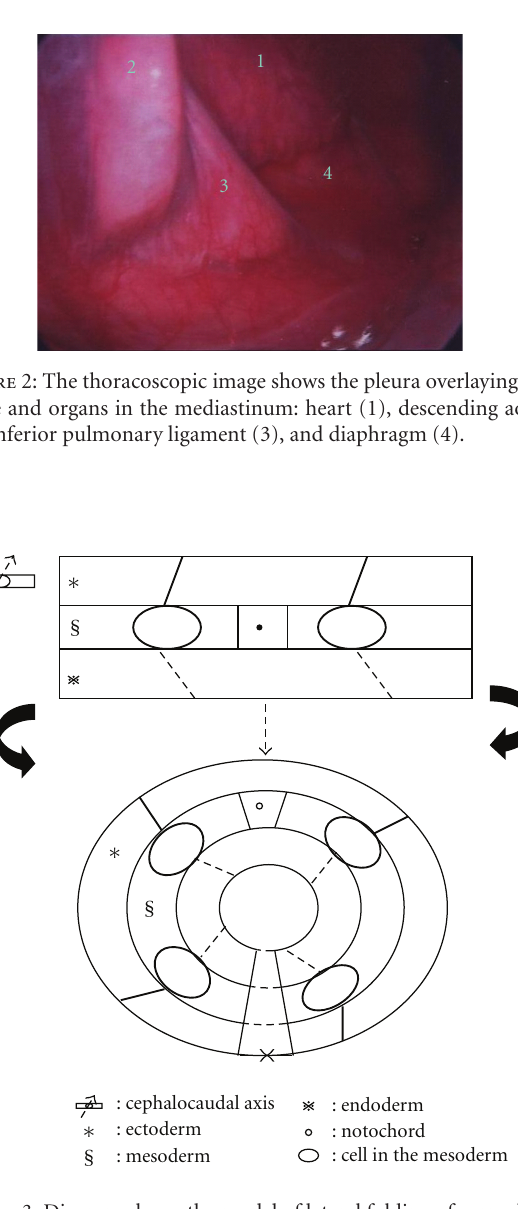
Figure 3: Diagram shows the model of lateral folding of germ disc.